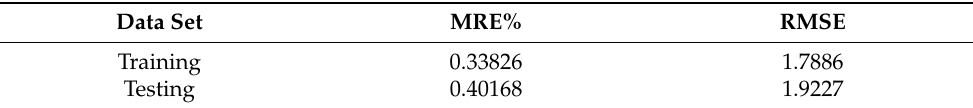
Table 3. Errors related to training and testing procedures.